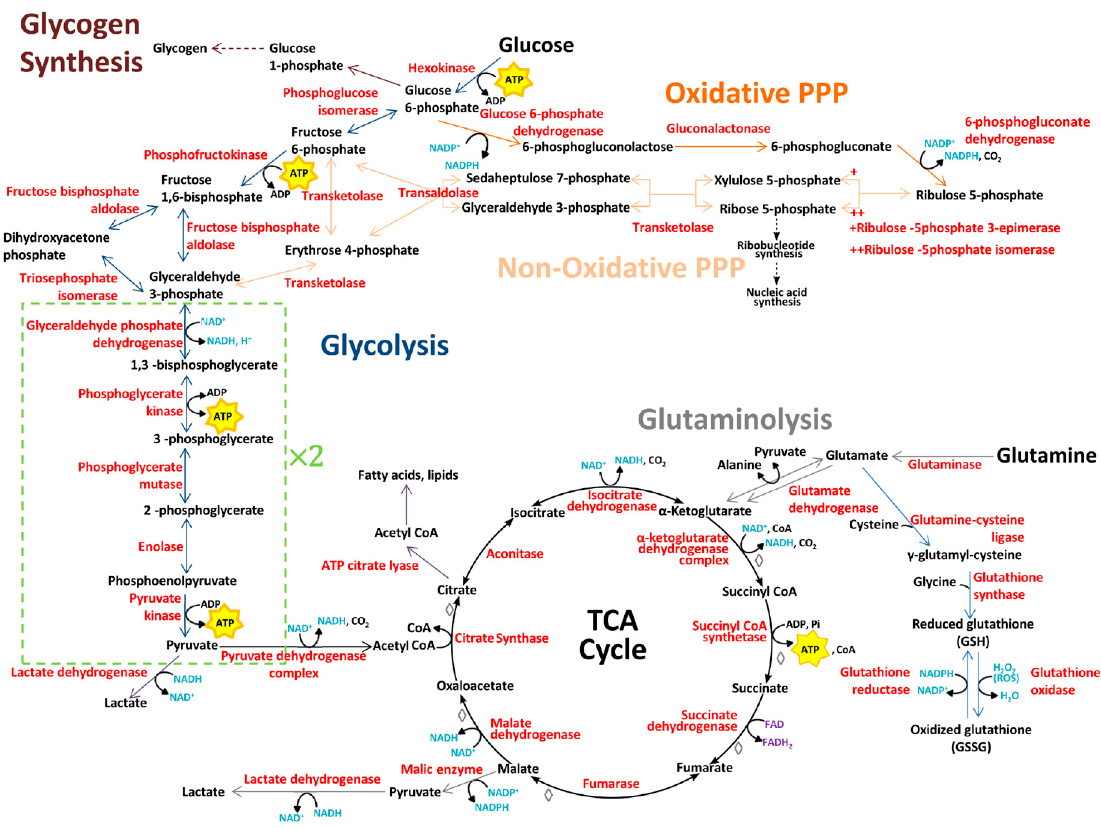
Figure 3. Overview of cellular glucose and glutamine metabolism. Glucose can undergo three fates: glycolysis (dark blue), glycogen synthesis (brown), or the pentose phosphate pathway (PPP), which has an oxidative (dark orange) and non-oxidative (light orange) phase. The TCA cycle (black) reactions that are recruited by glutaminolysis (gray) are marked ♦ . Enzymes are shown in red. ADP: adenosine diphosphate; ATP: adenosine triphosphate; CoA: coenzyme A; FAD: oxidized flavin adenine dinucleotide; FADH 2 : reduced flavin adenine dinucleotide; NAD + : oxidized nicotinamide adenine dinucleotide; NADH: reduced nicotinamide adenine dinucleotide; NADP + : oxidized nicotinamide adenine dinucleotide phosphate; NADPH: reduced nicotinamide adenine dinucleotide phosphate; P i : inorganic phosphate; ROS: reactive oxygen species.